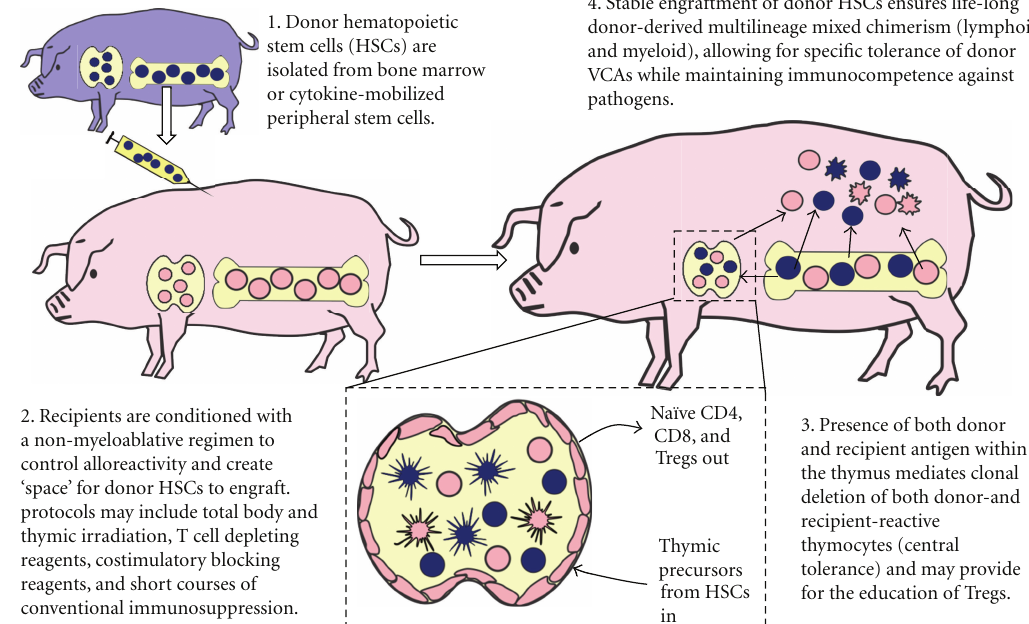
Figure 1: Mechanisms of tolerance in mixed